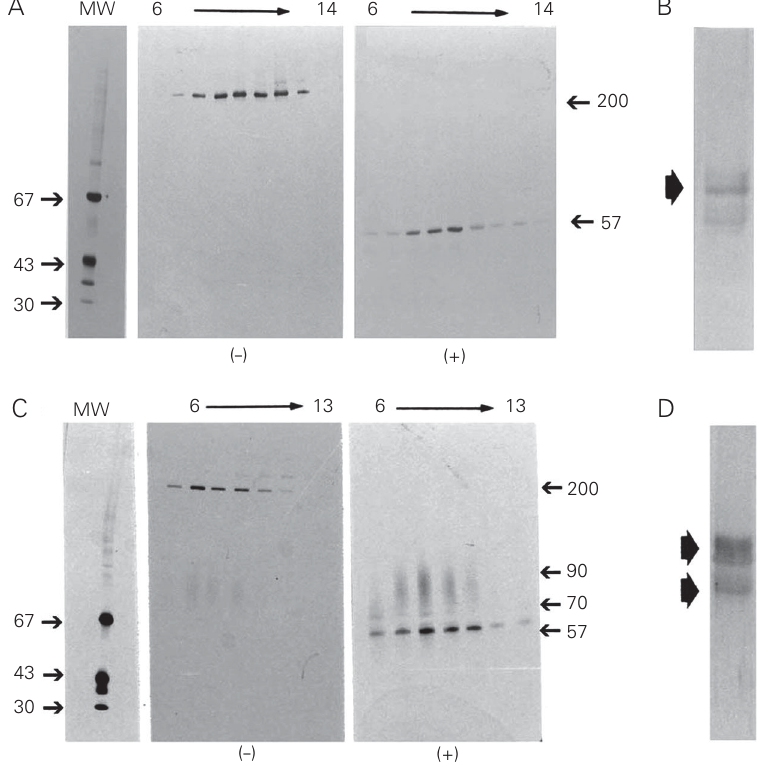
Figure 4. The eluate obtained by Octyl-Sepharose chromatography was analyzed by SDS- PAGE and immunoblotting to eventually characterize small proteoglycans of chicken wing cartilage. The D4 fraction from the region of the distal humerus in contact with the ulna was used but all regions showed the same pattern. A , SDS-PAGE showing the 200-kDa complex in the absence (-) of ß-mercaptoethanol, which appears as a 57-kDa component in the presence (+) of ß-mercaptoethanol. B , The 57-kDa molecule was identified as fibromodulin by immunoblotting. C , SDS-PAGE with eluates containing the 70-90-kDa component in the presence (+) and absence (-) of ß-mercaptoethanol, which was identified as decorin by immunoblotting (D). MW = molecular